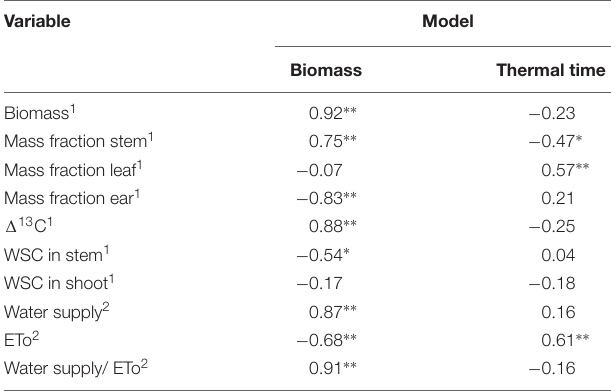
TABLE 4 | Correlation coefficients (r) between residuals from biomass and thermal time nitrogen dilution models, and shoot biomass, mass fraction of stem, leaf, ear, concentration of water-soluble carbohydrates (WSC) in stem and shoot, (cid:49) 13 C, water supply, cummulative reference evapotranspiration (ETo), and cummulative water supply per unit reference